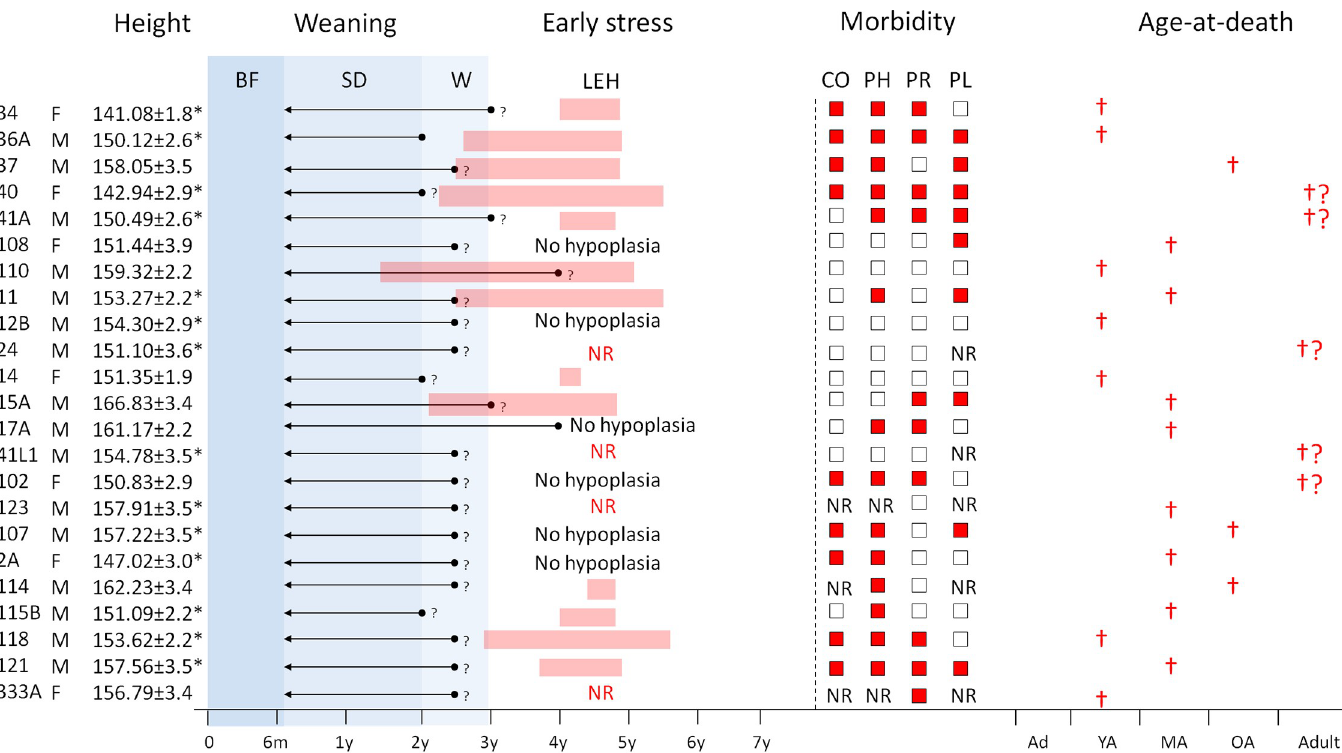
Fig 4. Physiological stress markers per individual in adults from Jabuticabeira